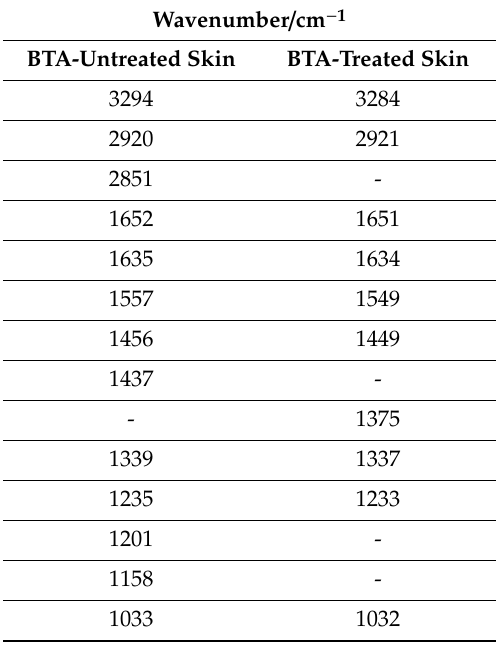
Table 16. Wavenumbers of infrared radiation absorption in the case of